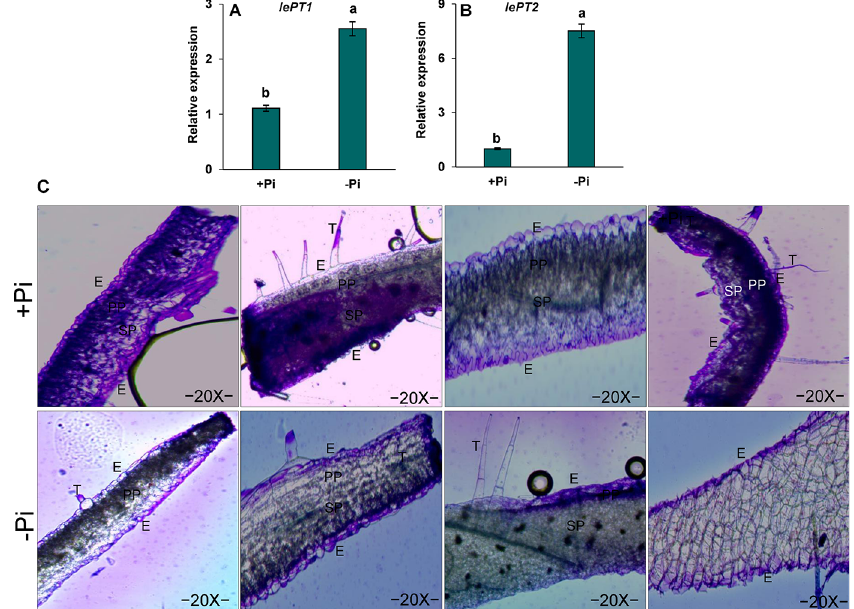
Fig 5. Relative expression and localization of phosphate transporters in leaves of tomato ( Solanum lycopersicum L.) to Pi starvation. One week after germination tomato plants were supplied with sufficient Pi (1 M KH 2 PO 4 ) or deficient Pi (0 M KH 2 PO 4 ) for 10 days. (A) Relative expression of lePT1 and lePT2; Vertical bars indicate Mean ± SE of the means for n = 3. Means denoted by the different letter are significantly different at P (cid:3) 0.05 according to the Tukey ’ s studentized range test (B) Localization of lePT1 and lePT2 observed under light microscope. E symbolizes epidermis, PP symbolizes palisade parenchyma, SP symbolizes sponge parenchyma, and T symbolizes